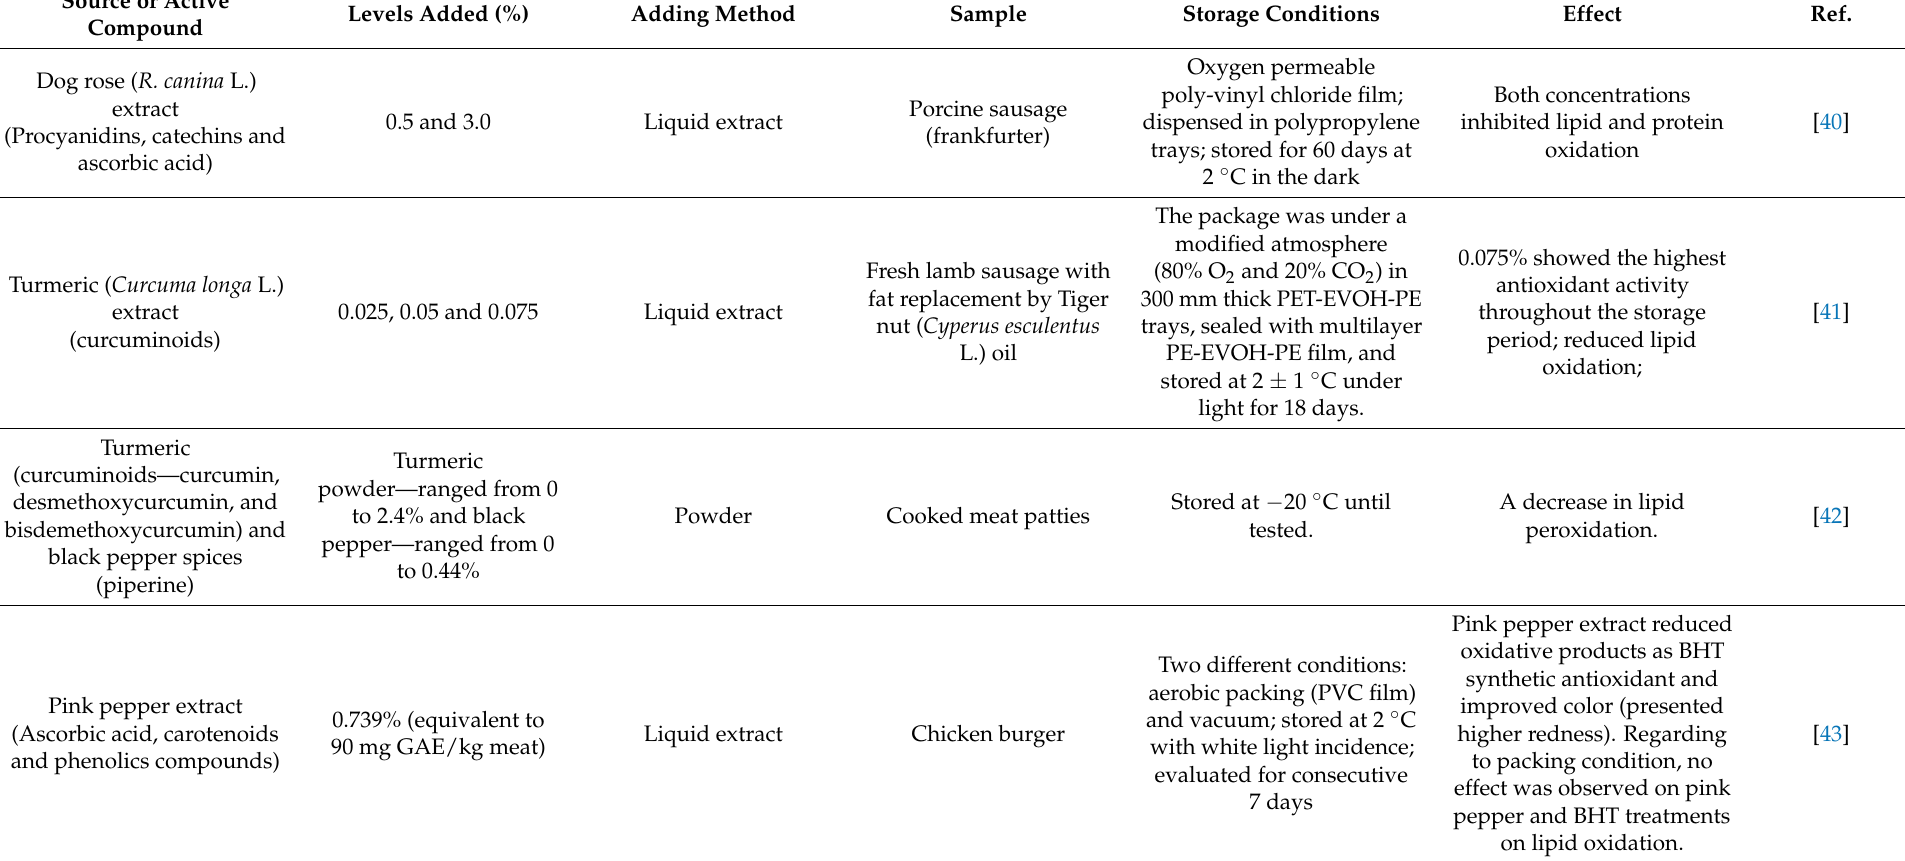
Table 2. Spices, their derived products, and essential oil as natural sources of antioxidants applied in meat